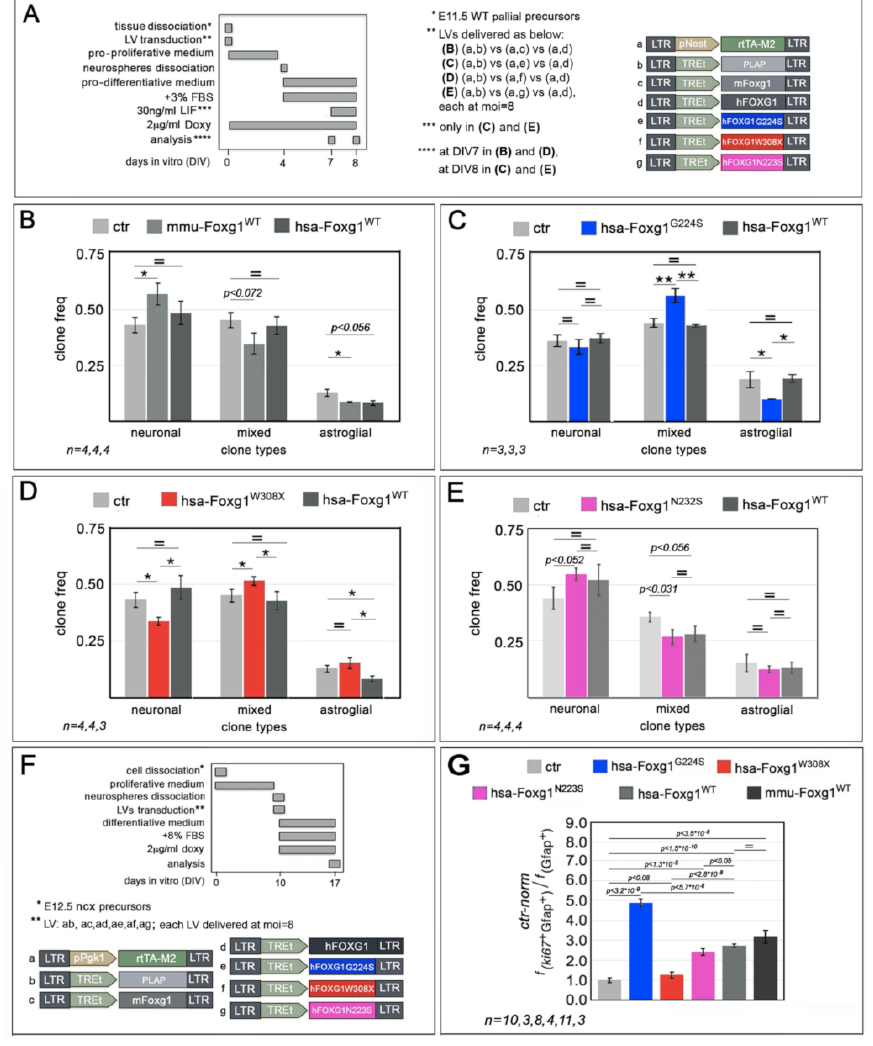
Figure 6. Impact of mutant FOXG1 alleles on astrogenesis progression in murine, primary neocortical cultures. ( A – E ) Impact of different FOXG1 alleles on fate choice, neuronal-vs-astroglial, by neocortical stem cells (NSCs), upon their lentiviral transduction with transgenes encoding for such alleles. In ( A ), protocols and lentiviral vectors employed, in ( B – E ), results. Shown are absolutes frequencies of neuronal, mixed and astroglial clones, generated by derivatives of E11.5 pallial NSCs upon acute ge- netic manipulation, intermediate expansion, and final differentiation at clonal densities. ( F , G ) Impact of different FOXG1 alleles on mitogenic properties of astrocyte-committed progenitors, upon their lentiviral transduction with transgenes encoding for such alleles, as assessed by means of Ki67/Gfap- immunofluorescence. In ( F ), protocol and lentiviral vectors employed, in ( G ), results. Shown are frequencies of intermitotic Ki67 + cells among Gfap + ones. Data normalized agaist Plap -expressing controls (absolute, control Ki67 + Gfap + /Gfap + ratio = 0.17). Throughout the Figure, statistical signifi- cance of results evaluated by t -test (1-tail, unpaired). * p < 0.05, ** p < 0.01, = not significant. n is the number of biological replicates, i.e., aliquots of pre-pooled, independently lentivirus-transduced, and cultured neural cells. Scalebars represent